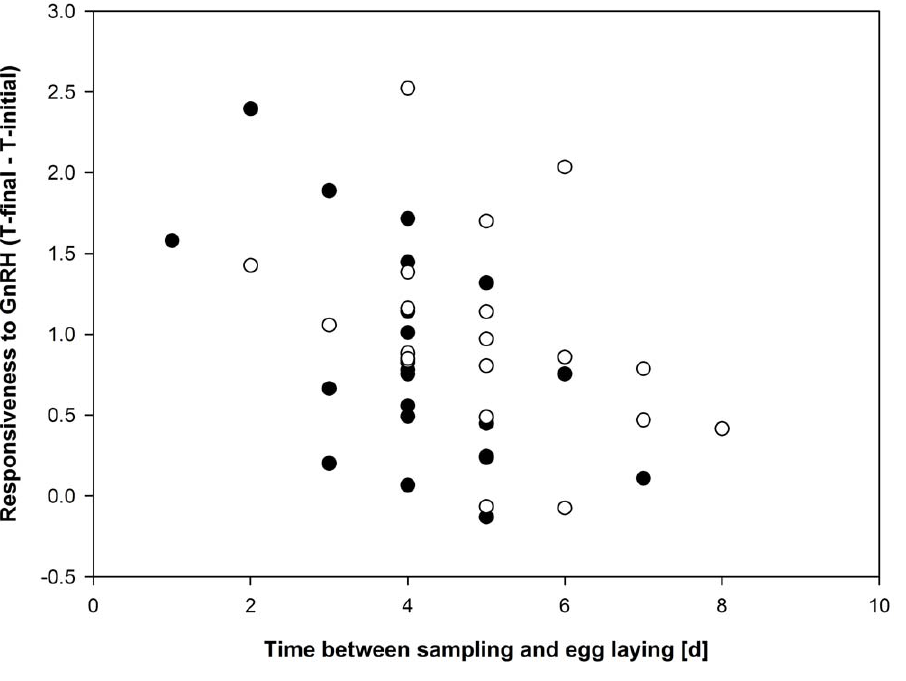
Figure 1. Increase in plasma testosterone concentrations following a challenge with gonadotropin-releasing hormone (GnRH). Increase in plasma testosterone concentrations (ng/ml) 30 min after injection of GnRH in relation to the laying stage. Data are split for females hatched from control-treated eggs (C-females, open circles) and females hatched from testosterone treated eggs (T-females, filled symbols).